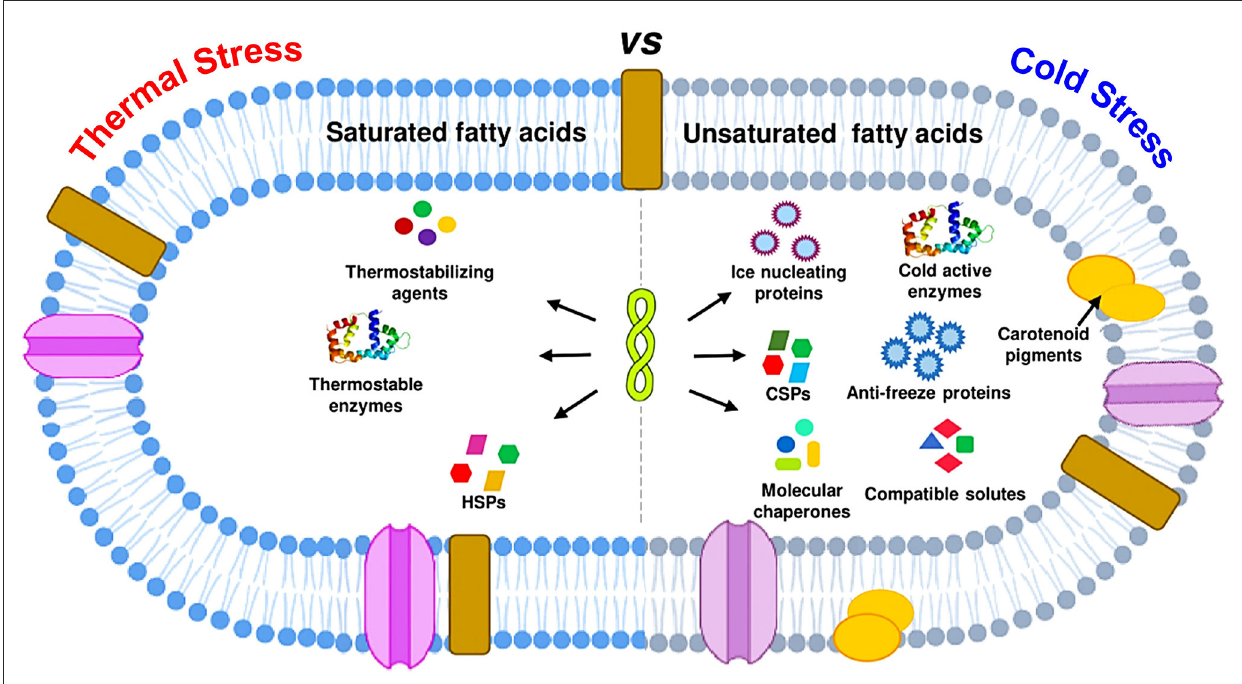
FIGURE1 A schematic diagram illustrating some crucial thermal and cold adaptations in cold-adapted microorganisms. Adapted with permission from Suyal et al. (2022).